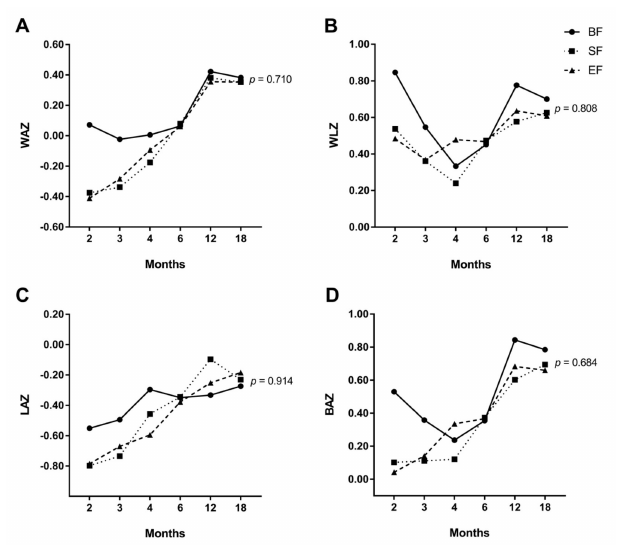
Figure 2. Generalized linear mixed model of repeated measures for z-scores for weight / age (WAZ) ( A ), weight / length (WLZ) ( B ), length / age (LAZ) ( C ), and body mass index (BMI) / age (BAZ) ( D ) in COGNIS infants. BF: breastfeeding; SF: standard infant formula; EF: experimental infant